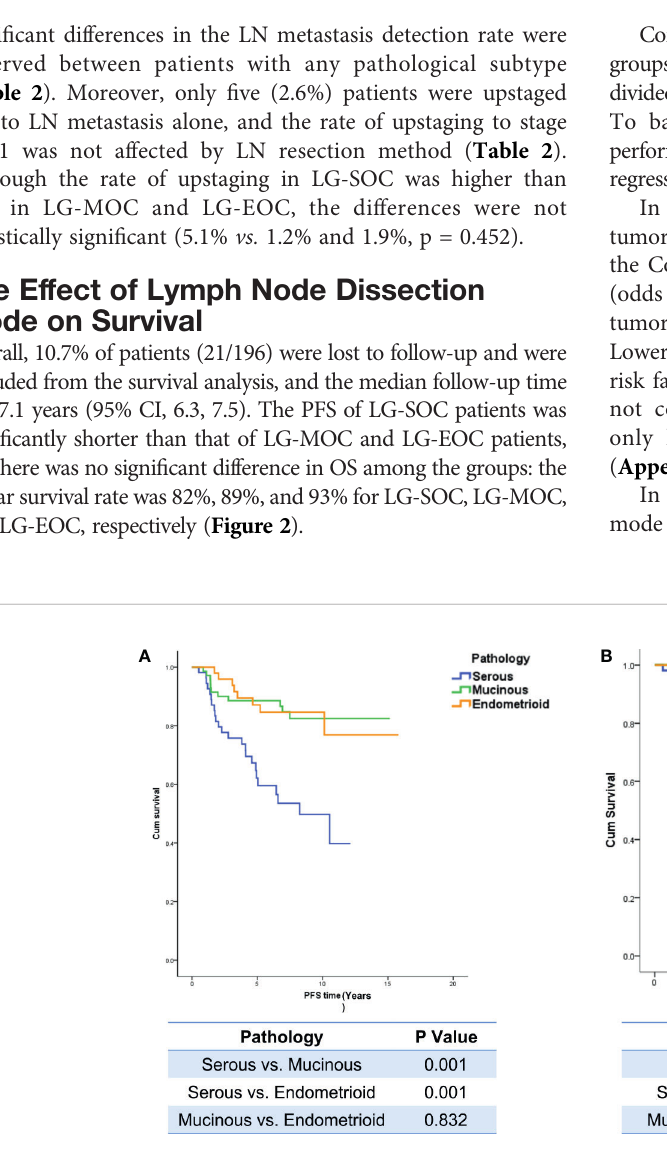
FIGURE 2 | The in fl uence of pathological types on PFS and OS. (A) The in fl uence of pathological types on PFS. (B) The in fl uence of pathological types on OS. The log-rank test was performed between any two pathological types, and a p-value of less than 0.05 was considered statistically signi fi cant. PFS, progression-free survival; OS, overall survival.